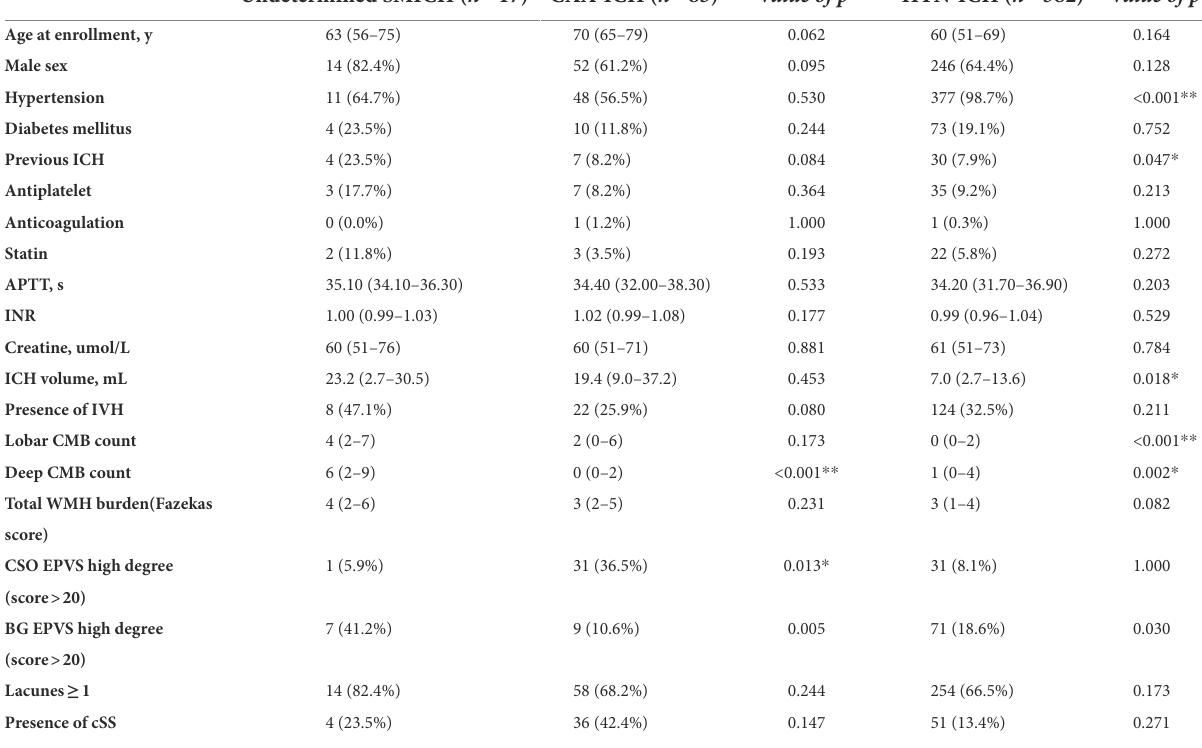
TABLE 2 Comparison of baseline demographics, clinical, and neuroimaging characteristics between patients with undetermined SMICH and those with cerebral amyloid angiopathy ICH and hypertensive angiopathy ICH. Undetermined SMICH ( n = 17) CAA-ICH ( n =